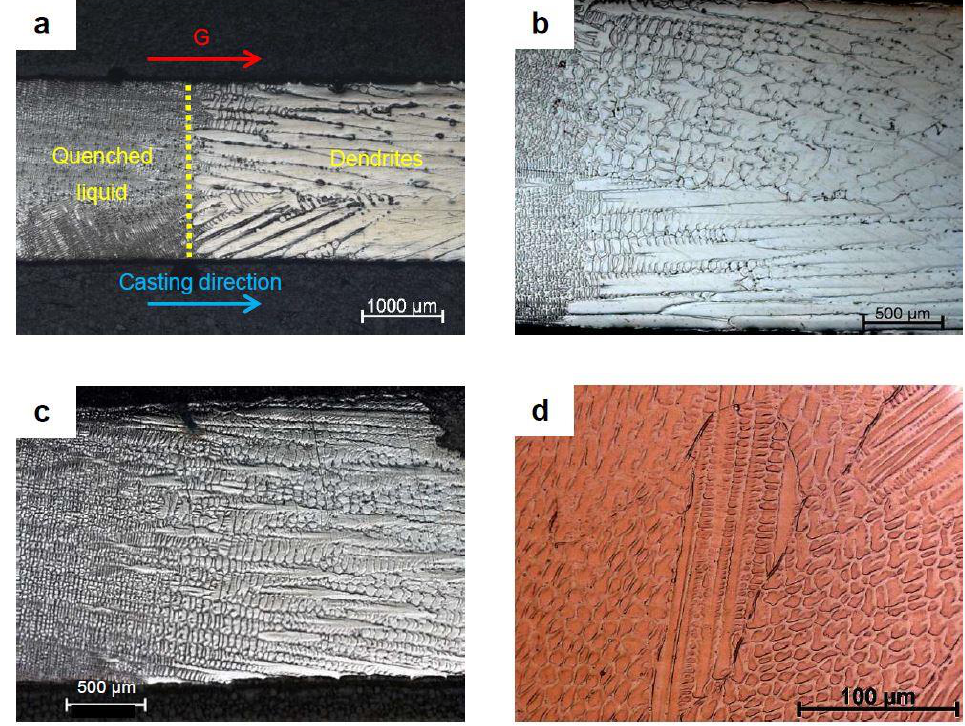
Figure 1. Micrographs for the secondary dendrite arm spacing (SDAS) measurement after electrolytic etching, using a 10 g H 2 C 2 O 4 with 100 mL H 2 O reagent, under the applied potential 4 V DC for 30–40 s: ( a ) QDS for a solidification velocity V = 0.013 mm/s and thermal gradient ( G ) = 3000 K/m; ( b ) QDS for V = 0.03 mm/s and G = 5300 K/m; ( c ) QDS for V = 0.09 mm/s and G = 5300 K/m; and ( d ) gas tungsten arc welding (GTAW).